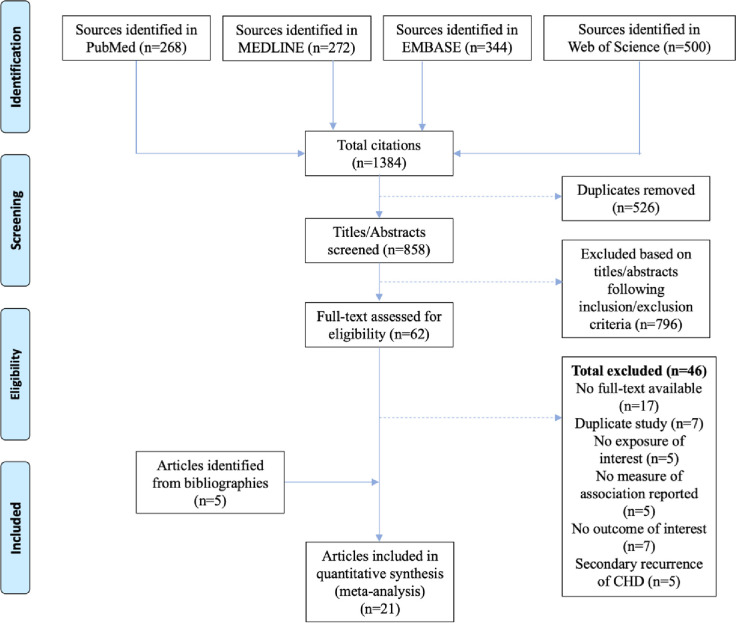
Systematic review PRISMA flow diagram.